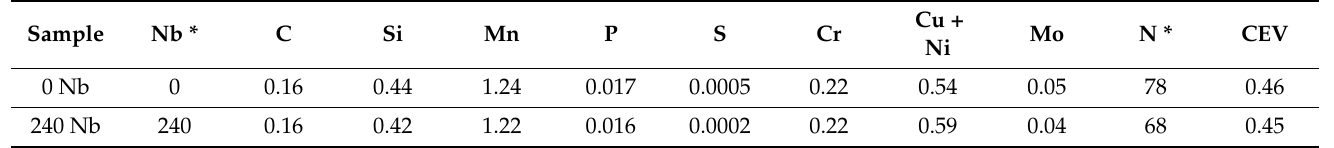
Table 1. Chemical composition of the studied C-Mn steel plates (in mass